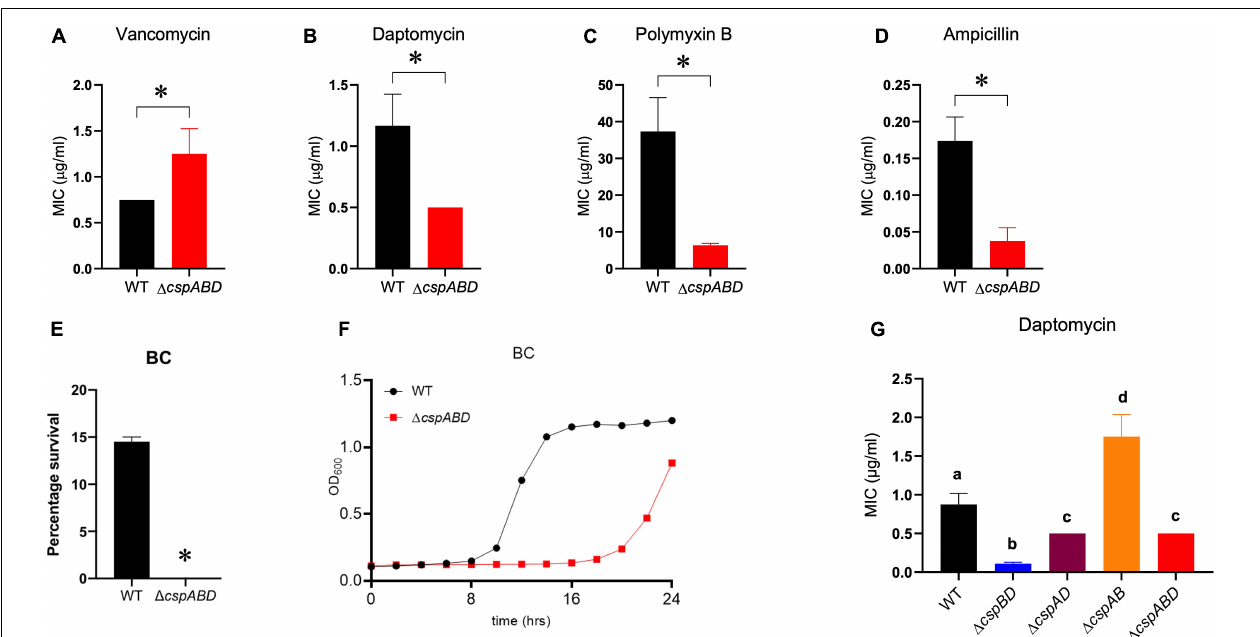
FIGURE 5 | Impact of Csp deficiency on BC and antibiotic susceptibility of L. monocytogenes . Comparison of vancomycin, daptomycin, polymyxin B, ampicillin, and BC stress sensitivities between EGDe wild type (WT) and triple ( (cid:49) cspABD ) and double ( (cid:49) cspBD , (cid:49) cspAD , and (cid:49) cspAB ) csp deletion mutants. The minimum inhibitory concentrations (MICs) for vancomycin (A) , daptomycin (B,G) , polymyxin B (C) , and ampicillin (D) were determined using the E -test. (E) WT and (cid:49) cspABD strains were exposed BC (10 ppm) at 25 ◦ C for 15 min, and survival expressed as a percentage was measured as the number of colony-forming units determined after BC exposure normalized to the number of unstressed cells present at the beginning of stress exposure. (F) Growth of WT and (cid:49) cspABD strains in BC (1.2 ppm)-supplemented BHI. Results are based on three independent experiments performed in duplicates. ∗ P < 0.05, statistically significant differences between WT and (cid:49) cspABD mutant identified using the t -test for independent samples. Different letters indicate significant differences between WT and the csp mutants daptomycin MICs that were identified using one-way ANOVA and Tukey post-hoc test pairwise comparison of all the strains ( p <